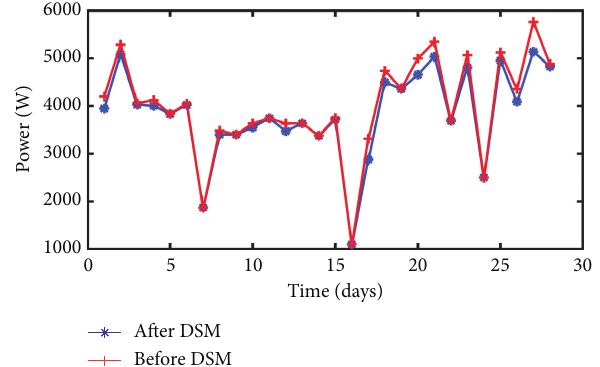
Figure 19: Total load profile before and after the implementation of DSM for all the targeted clusters.